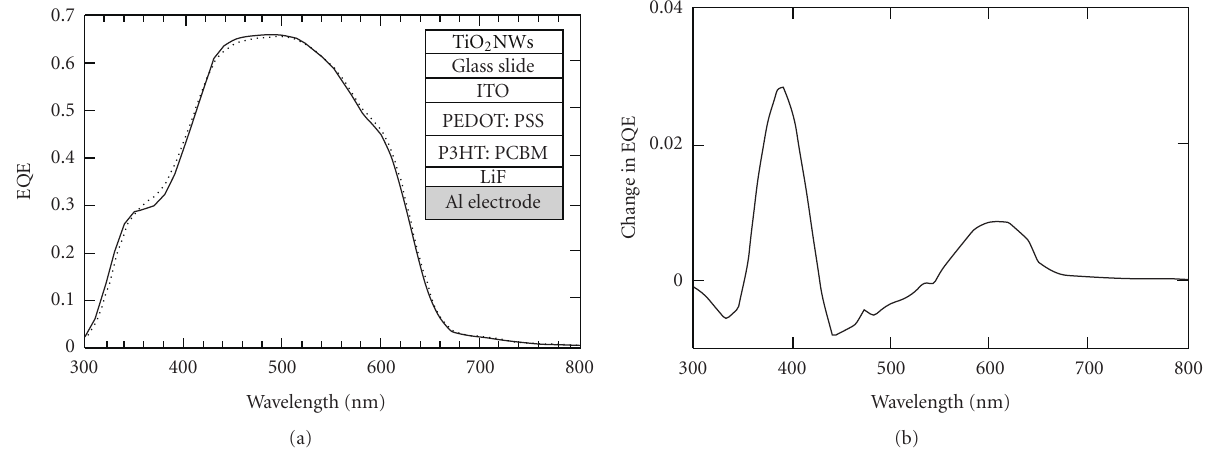
Figure 5: (a) External quantum e ffi ciencies (EQE) of BHJ organic solar cells with (broken line) and without (solid line) the TiO 2 NW coating. (b) A change in EQEs between with and without the NW